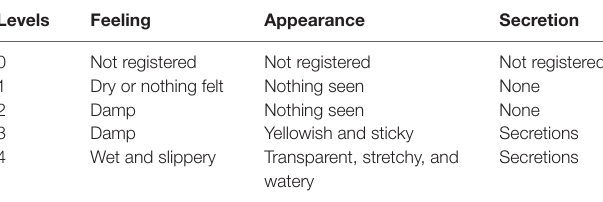
Table 1 | Classification of cervical mucus symptoms and